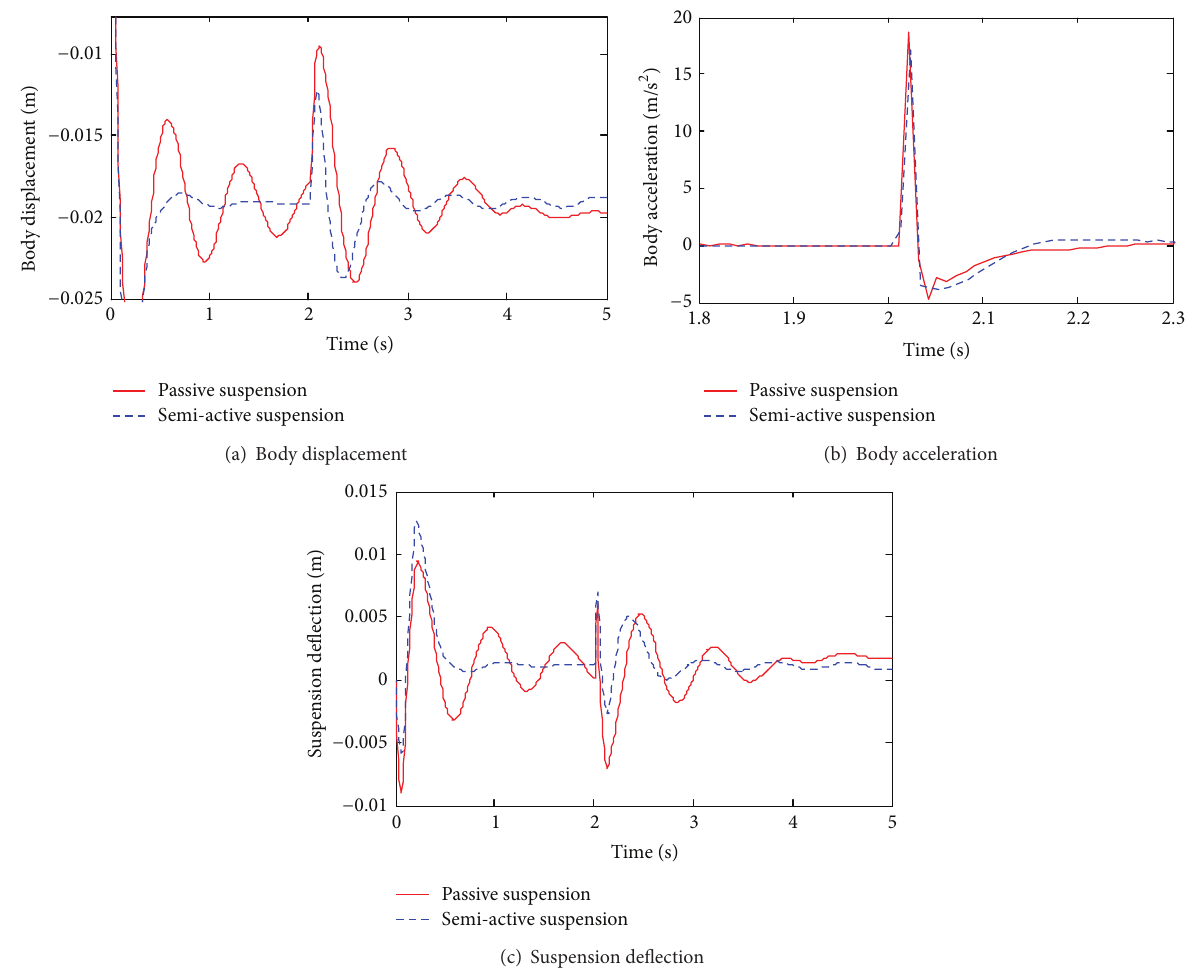
Figure 5: Suspension system to the first situation.